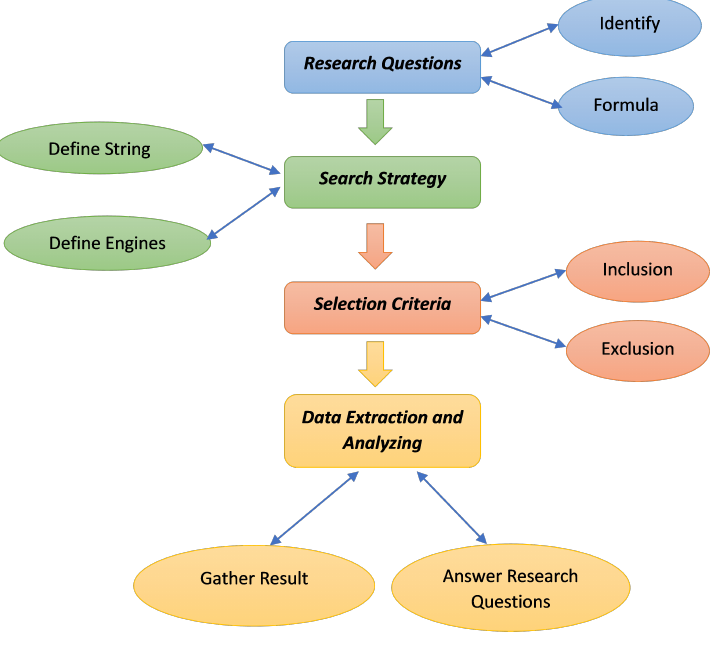
Figure 1. Survey protocol